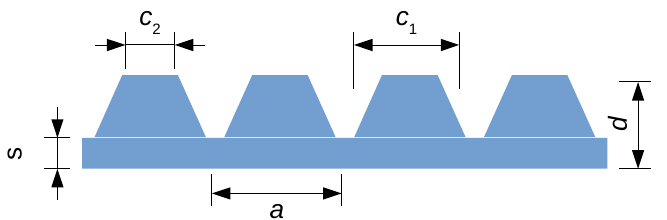
Figure 9. A simple model of pin convective heat skin. The structure is periodic in the two horizontal directions, with lattice parameter a. The protrusions are truncated pyramids with square bases of edge size c 1 > c 2 >